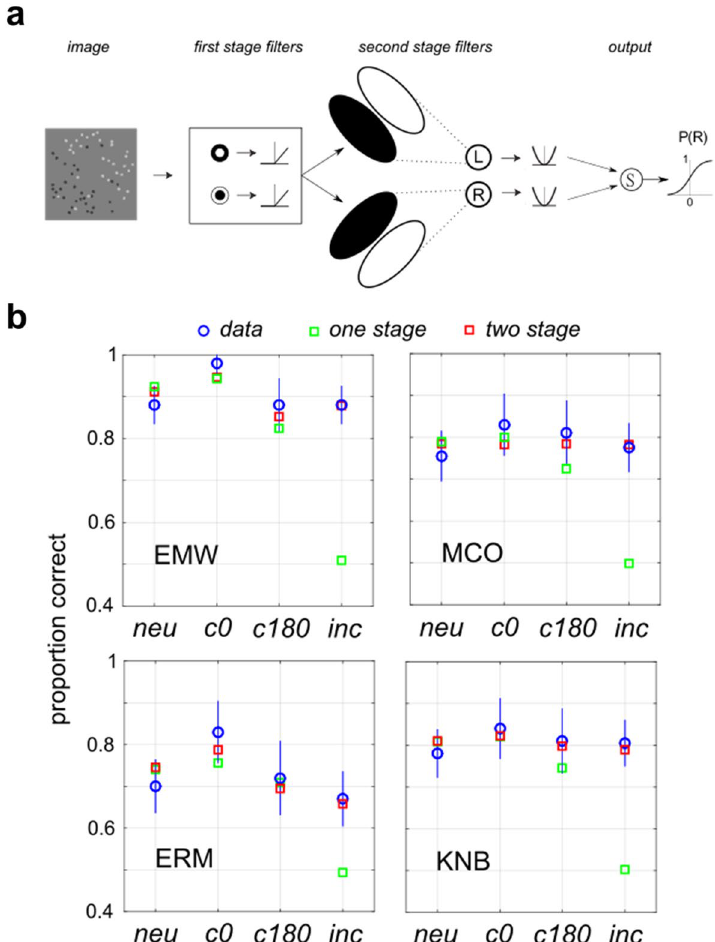
Figure 8. Two-stage model fits Experiment 4 results. ( a ) Model with two cascaded stages of filtering (IC-2). The first stage of this model detects texture elements (here, micro-patterns) on a fine spatial scale. The second stage looks for differences in the outputs of these first-stage filters on the coarse spatial scale of the texture boundary, at either of two possible orientations. Such a model can detect differences in the proportions of black and white micro-patterns on opposite sides of the boundary, while being fairly robust to interference from luminance steps. ( b ) Fits of single-stage model IC-1 (green squares) and two-stage model IC-2 (red squares) to data from Experiment 4a (blue circles, lines denote 95% confidence intervals), for four ways of combining LTB and LSB stimuli: neutral ( neu ); congruent, in-phase ( c0 ); congruent, opposite phase ( c180 ); and incongruent ( inc